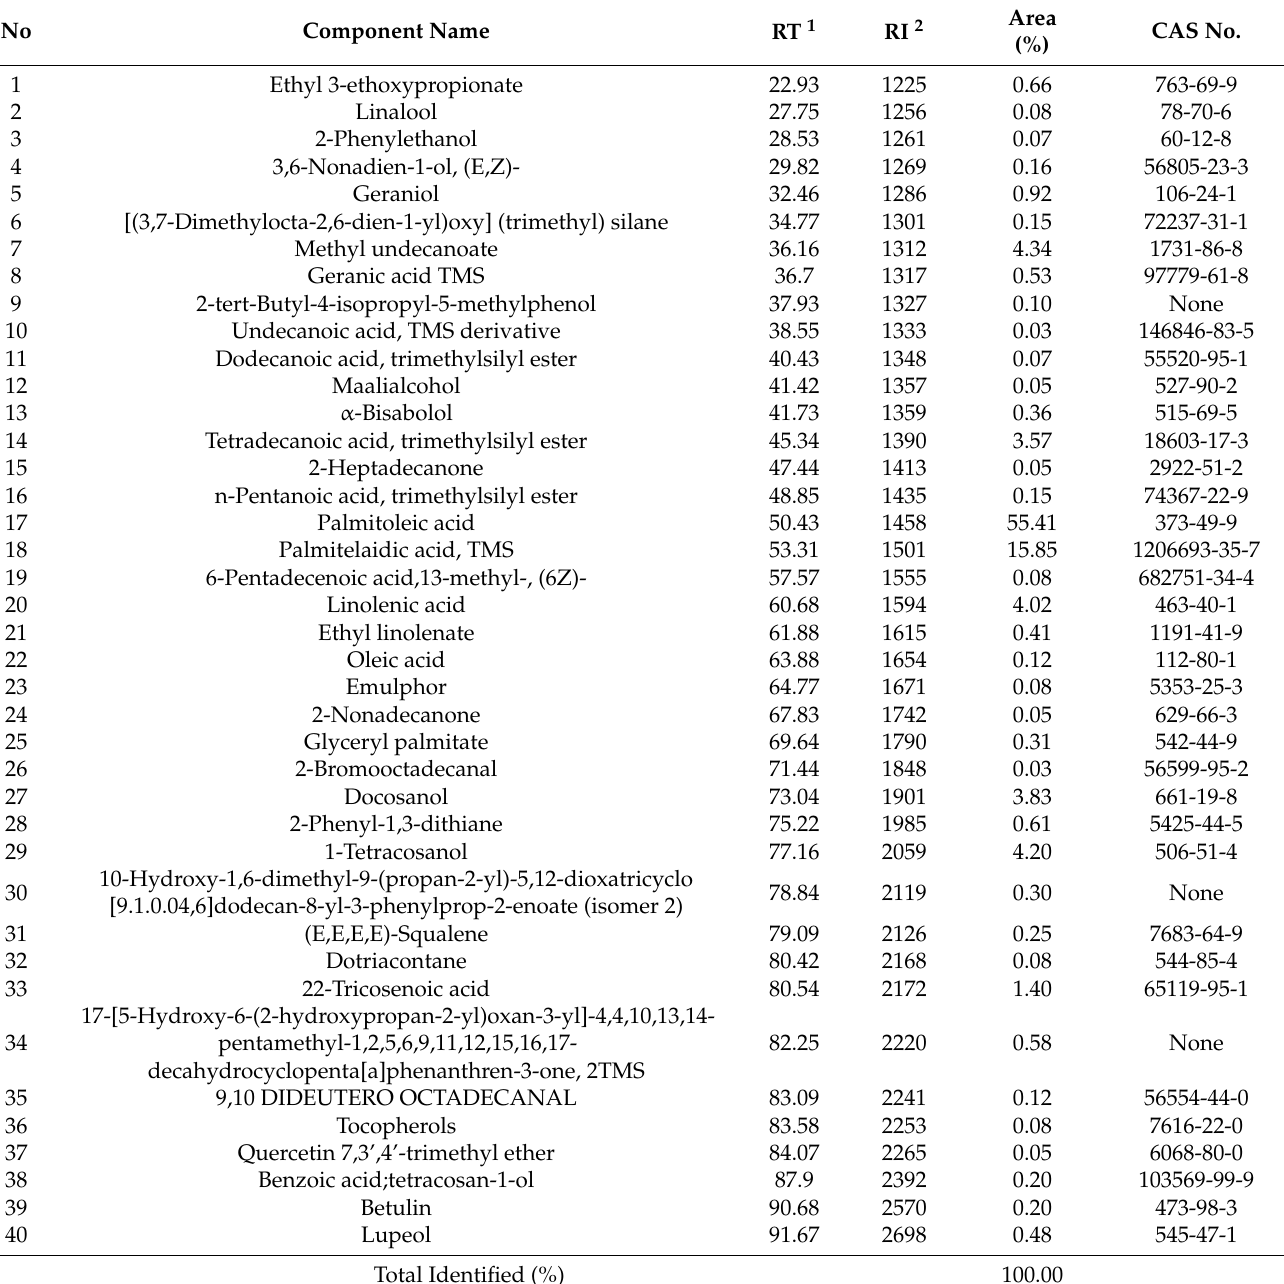
Table 1. Components of Impatiens textori Miq. flower